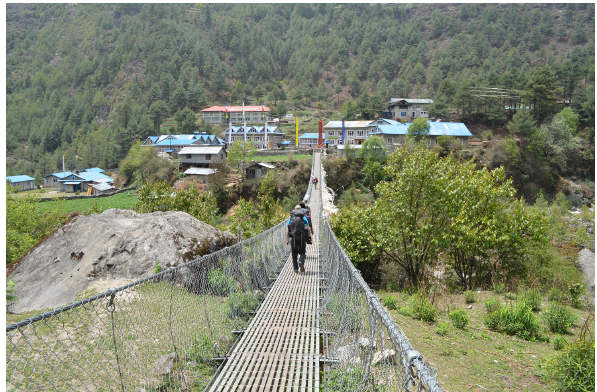
Figure 3. Bridge across the Dudh Koshi at the Star Lion Resort near the village of Phakding showing the bridge and the relative height from the river course to the arable land and houses (about 10 to